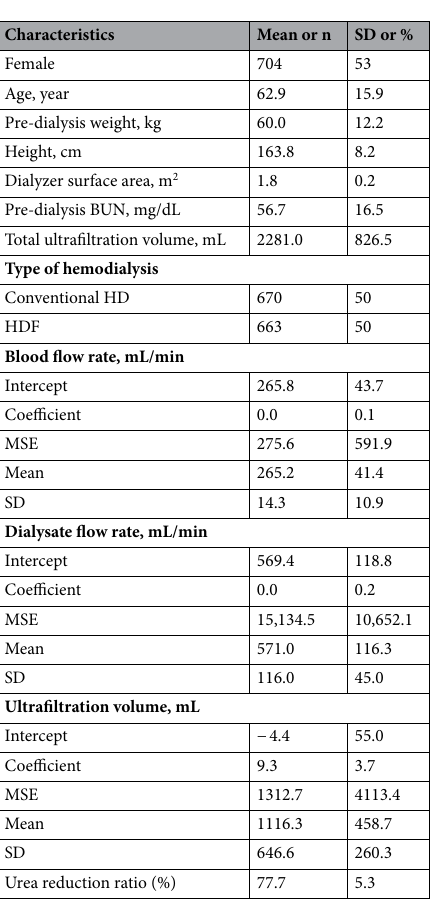
Table 1. Study subject characteristics (61 subjects, 1333 sessions). SD standard deviation, BUN blood urea nitrogen, HD hemodialysis, HDF hemodiafiltration, MSE mean square